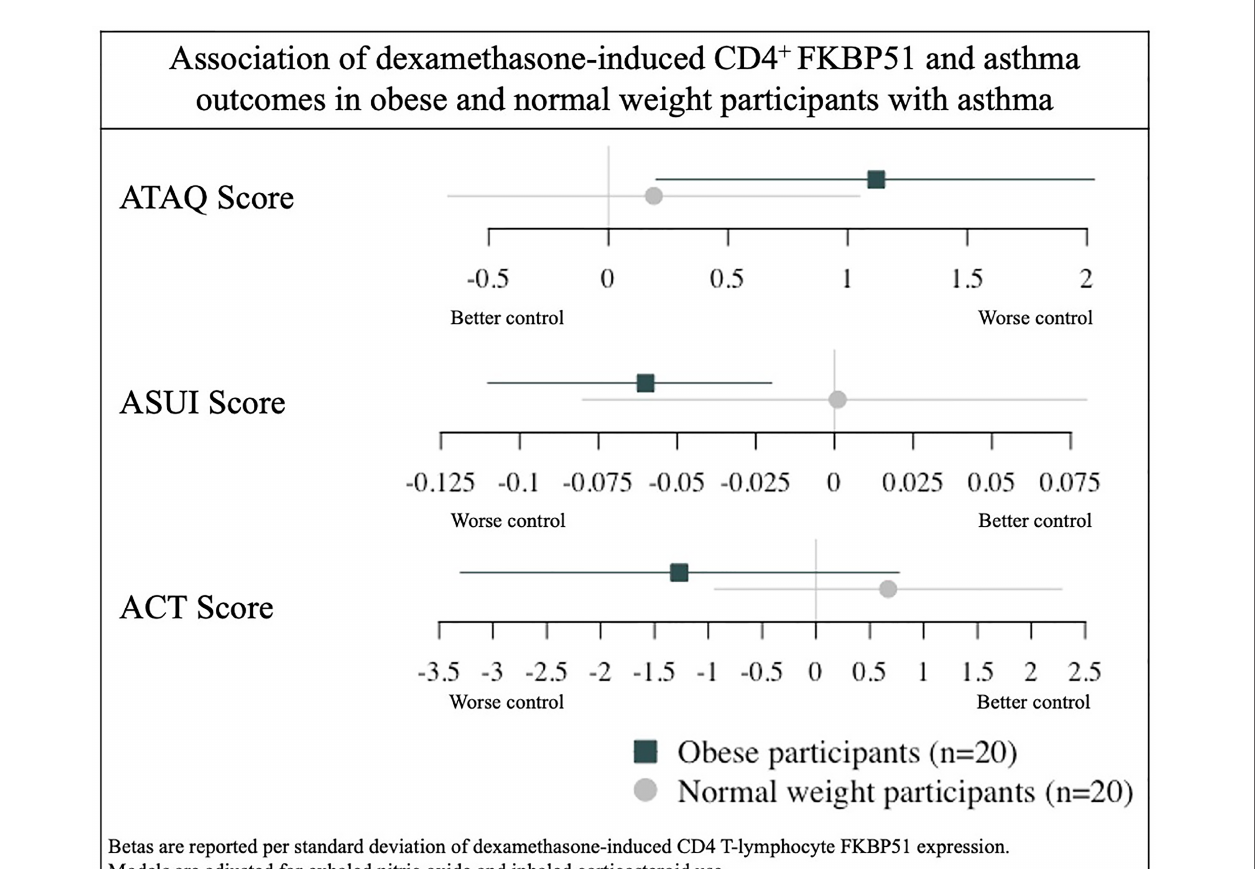
FIGURE 1 | Association of dexamethasone-induced CD4+ FKBP51 and asthma outcomes in obese and normal weight participants with